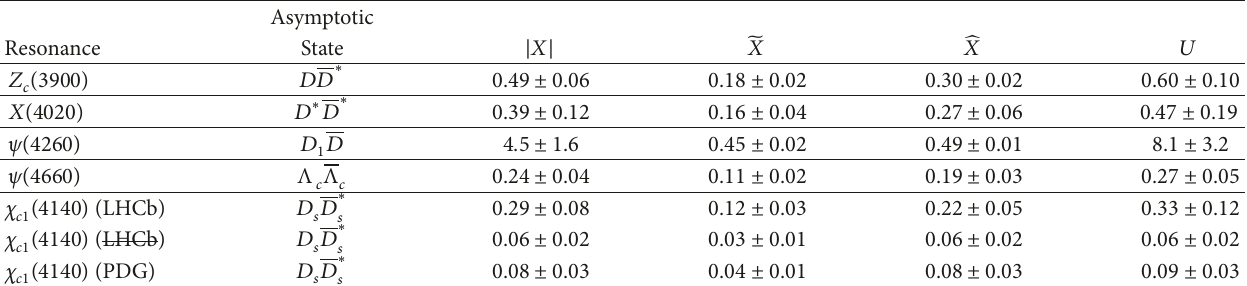
|̃𝑋| |̂𝑋| Table 2: Set of numbers |𝑋| , [15], [16] and 𝑈 [15–17] for the resonances considered in Table 1. No criteria for the probabilistic interpretation of the compositeness is met in the case of the 𝜓 (4260)